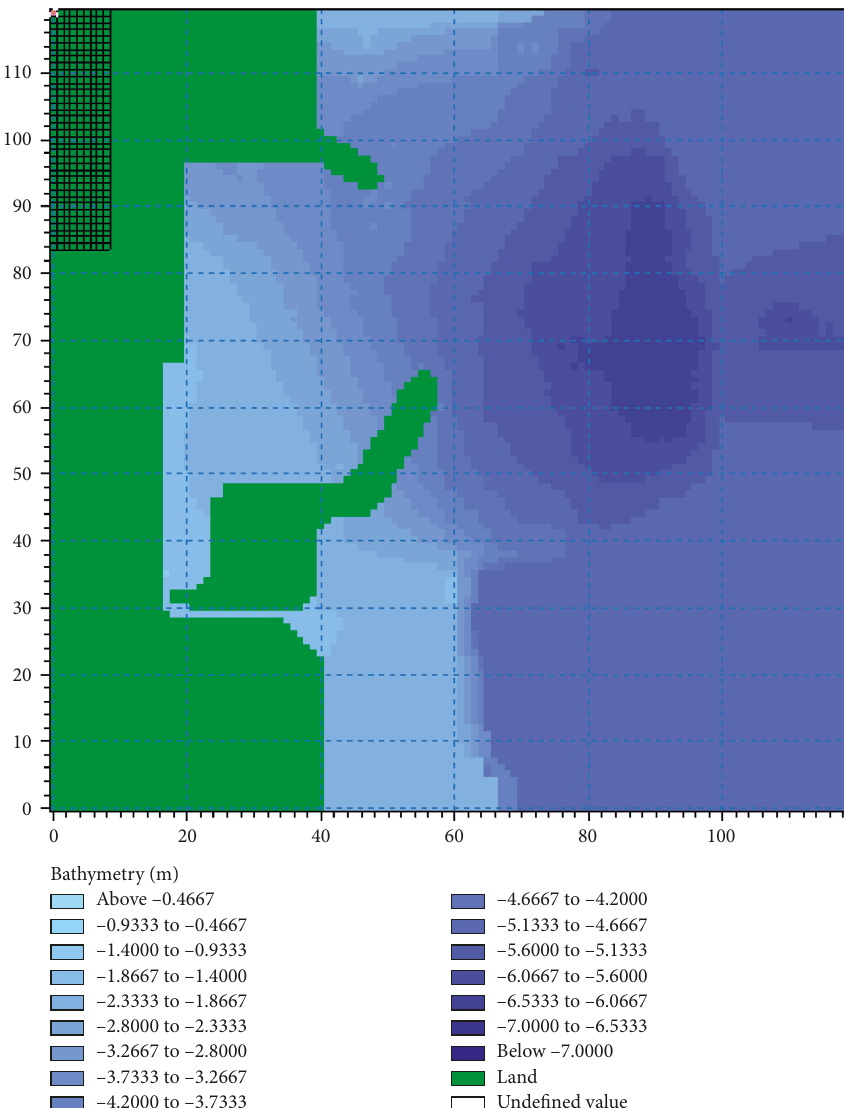
Figure 9: Bathymetry at the Saras